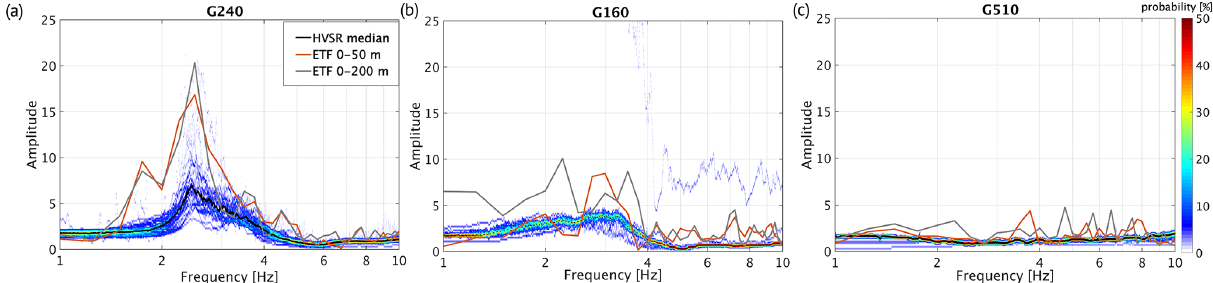
Figure 5. Probability density function of 1 month of daily HVSRs and the mean HVSR (solid black line) and ETF for the borehole seismome- ter interval of 0–50m (grey dashed line) and 0–200m (grey solid line). The selected borehole sites exhibit differences in curve characteristics with (a) G24 illustrating clearly peaked curves ( > 4), (b) G16 illustrating medium (2–4) peak amplitudes, and (c) G51 with no pronounced